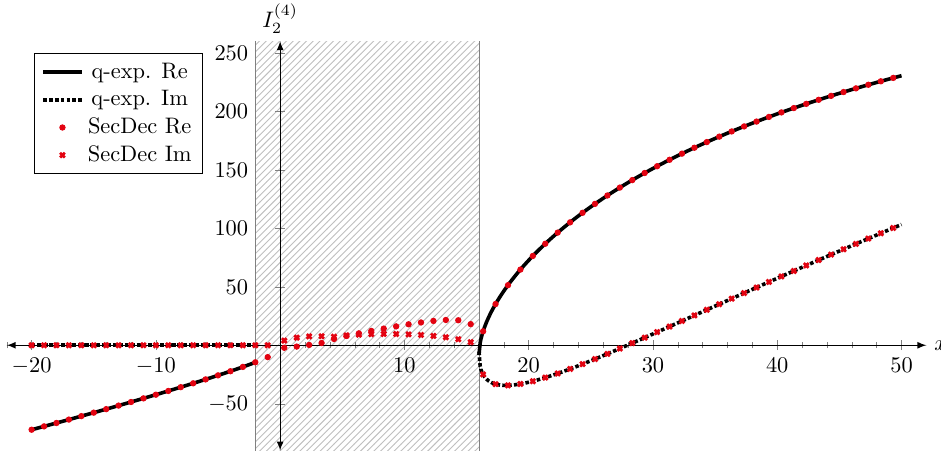
Figure 5 . Comparison of our result for I (3) converges for all points except x = 0 .